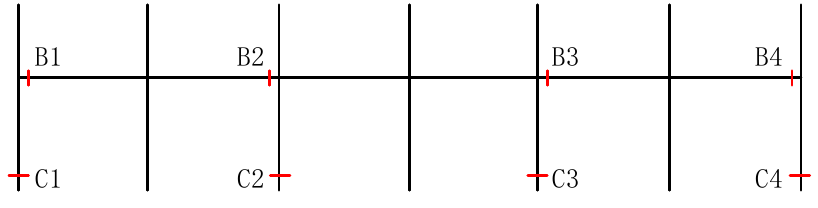
Figure 14. Numbering of key sections.